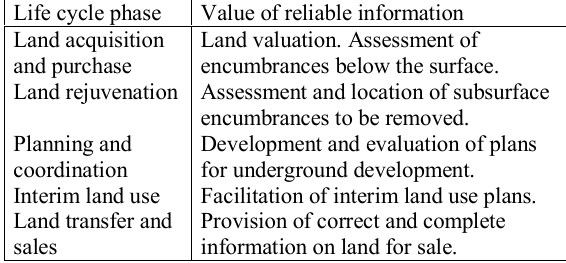
Table 1. Value of reliable information for land administration